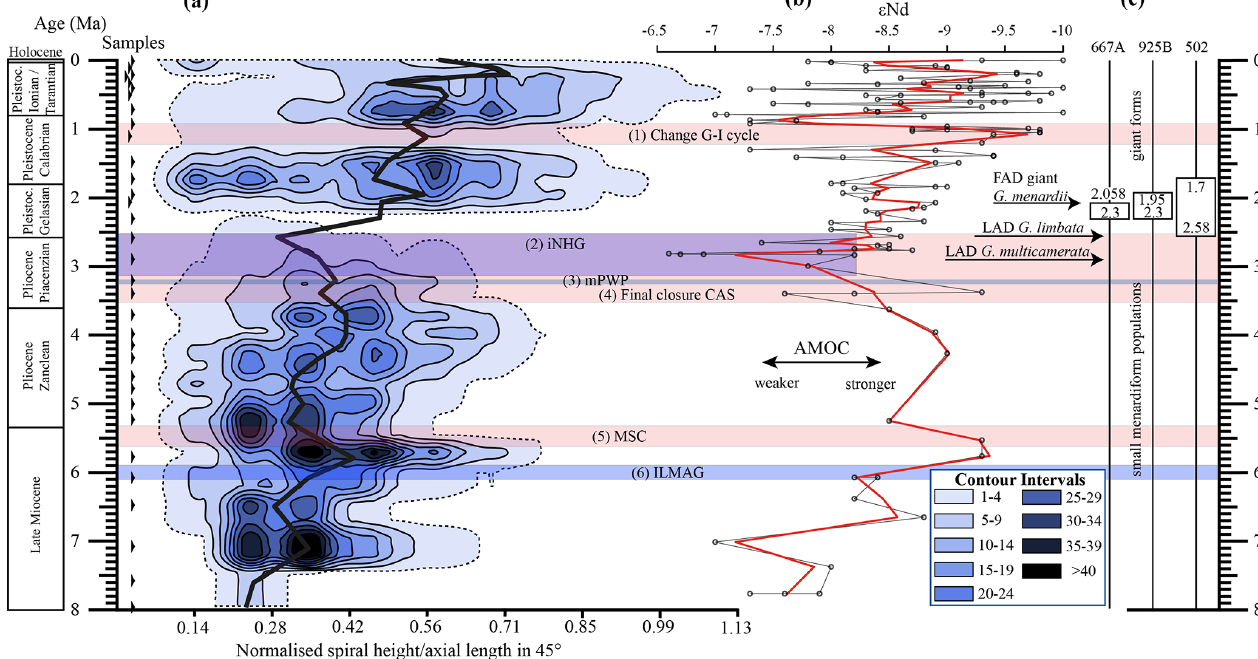
Figure 10. (a) Longitudinal section (offset value = 0) through the 45 ◦ view on the volume density diagram of Hole 667A in a palaeoceano- graphic context. The dotted line represents a density of one specimen per grid cell, and solid lines are contours at density intervals of five specimens per grid cell. The evolution of mean values through time is shown as a thick black line. (1) The time interval in which a shift to increased amplitude of glacial–interglacial cycles and a corresponding 100Kyr fluctuation in ice sheets is observed (Clemens et al., 1996; Ivanova, 2009). (2) The cooling trend, which leads into the NHG (Chapman, 2000). (3) The mid-Pliocene warm period (mPWP; Haywood et al., 2016). (4) The time interval in which the final closure of the Central American Seaway (CAS) is supposed by Bartoli et al. (2005), Jackson and O’Dea (2013), and O’Dea et al. (2016). (5) The time interval of the Mediterranean salinity crisis (Krijgsman et al., 1999). (6) The intensification of the Late Miocene Antarctic Glaciation (ILMAG) (Chaisson and Ravelo, 1997). (b) The right side shows ε Nd isotopic curve at Site 1088 in the South Atlantic taken from Dausmann et al. (2017), a proxy for the AMOC strength. The black line with circles represents the original data from Dausmann et al. (2017) and the red line a smoothed version, produced with the RStudios’ command “smooth.spline” at the value of 0.35. (c) The black triangles on the left side display the investigated samples. The boxes on the right side show the time intervals in which the giant G. menardii specimens occurred at Sites 667, 925 and 502 and in which the size increase is presumed to have taken place. The arrows show the first appearance date (FAD) of giant G. menardii specimens and the last appearance date (LAD; more than one specimen per sample split) of G. limbata and G. multicamerata at Site